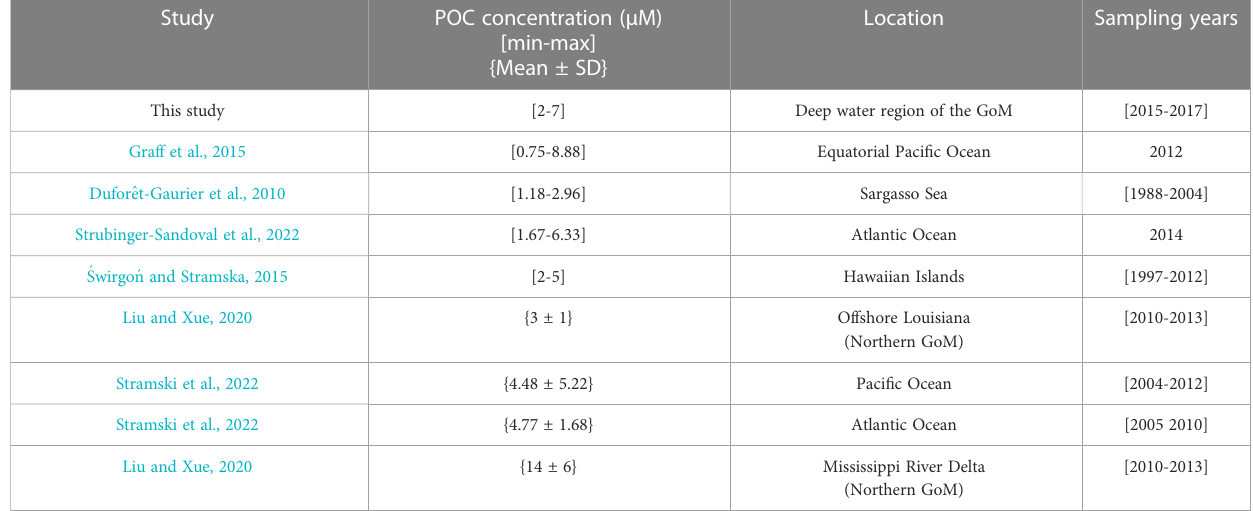
TABLE 6 Particulate organic carbon concentrations from different study